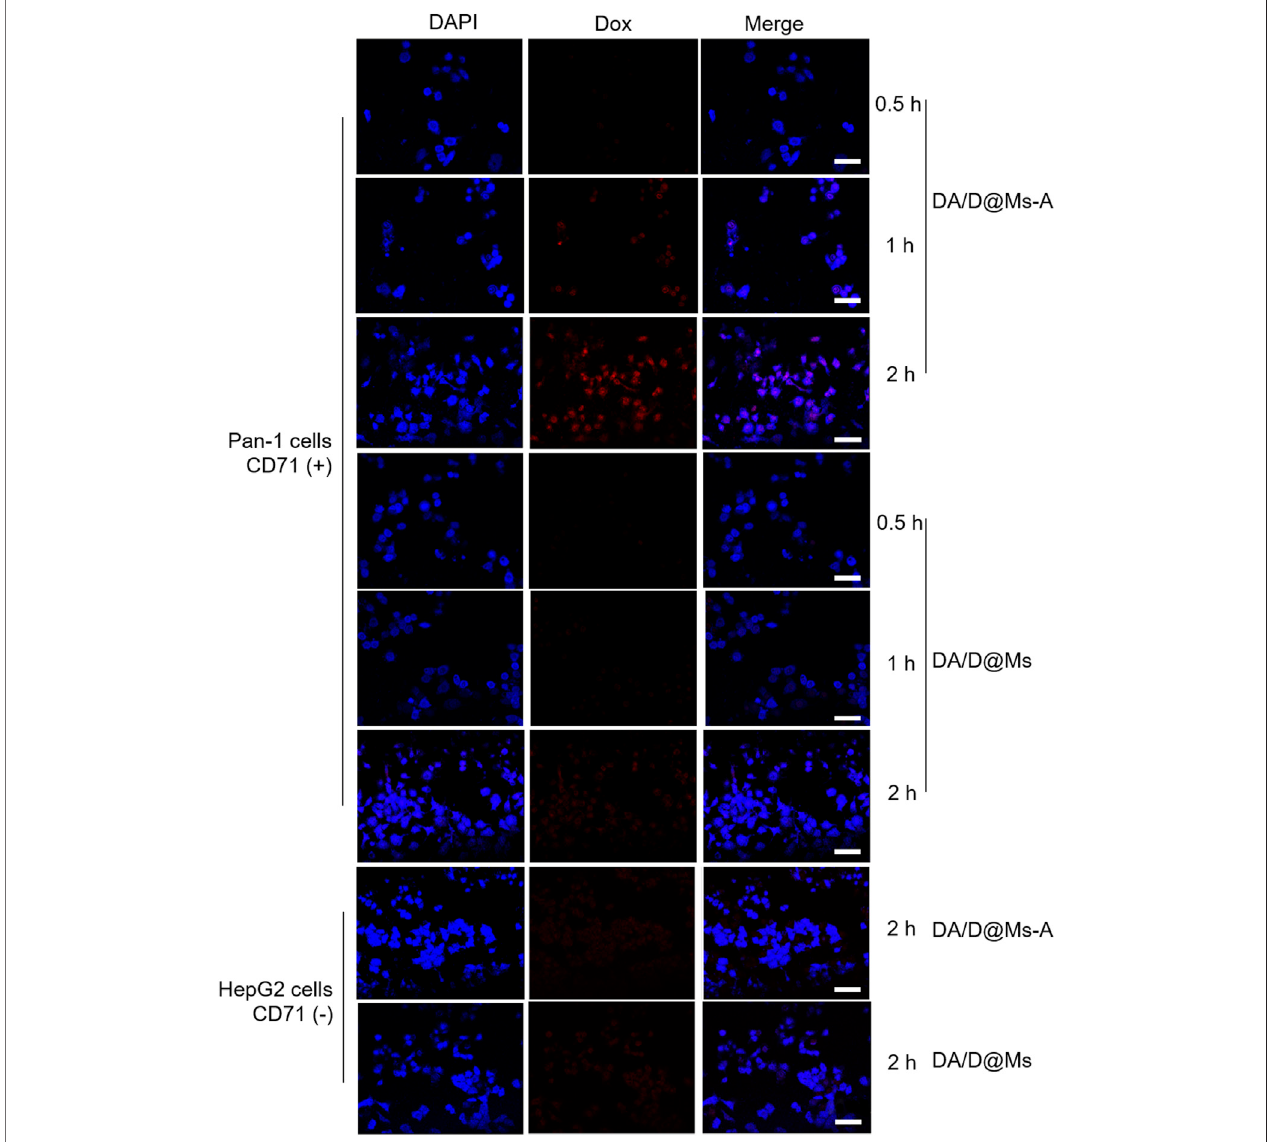
FIGURE3| CLSM images ofPanc-1cellsand HepG2 cells incubated with 0.01 mg/ml DA/D@Ms-A and DA/D@Msfor0.5, 1, and 2 h, respectively. DAPIchannel withexcitationwavelengthat405 nmexhibitsblue fl uorescencefromDAPIstainedcellnuclei.Doxchannelwithexcitationwavelengthat488 nmshowsred fl uorescence from Dox. Scale bar = 50 μ